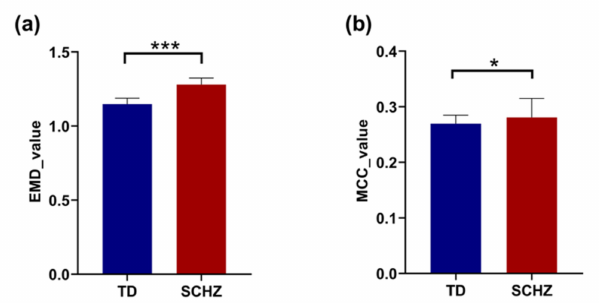
Figure 4. Panels ( a , b ) represent the differences in the entropy of the multiplex degree (EMD) and multilayer clustering coefficient (MCC) at the whole-brain level between control subjects and patients with schizophrenia (SCHZ), respectively. * indicates 0.01 < p < 0.05, *** indicates p =